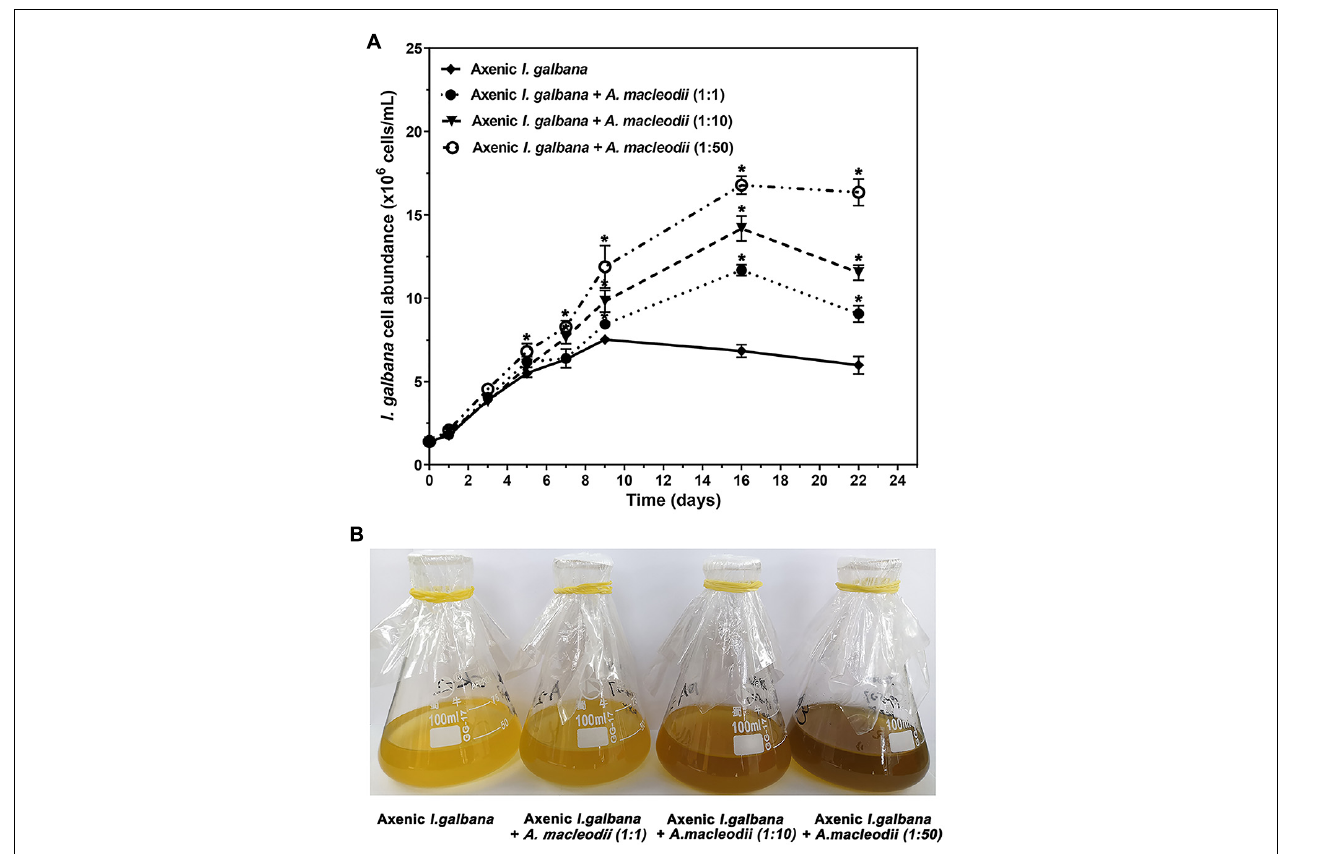
FIGURE 1 | Co-cultures results of I. galbana and A. macleodii with three different initial bacteria/algae ratios of (1:1, 1:10, and 1:50) expressed as cell abundance (A) and the color of algal fluid (B) . Significance of the differences between mean values was determined with Student’s t test. Error bars represent standard error (SE), while asterisks (*) indicate significant difference at p value <